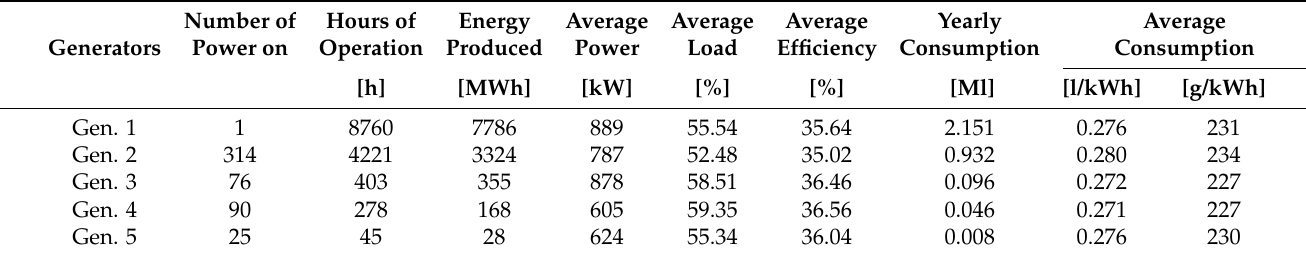
Table 5. Annual operating data of the generators on the typical year (average of the years 2015 and 2016).